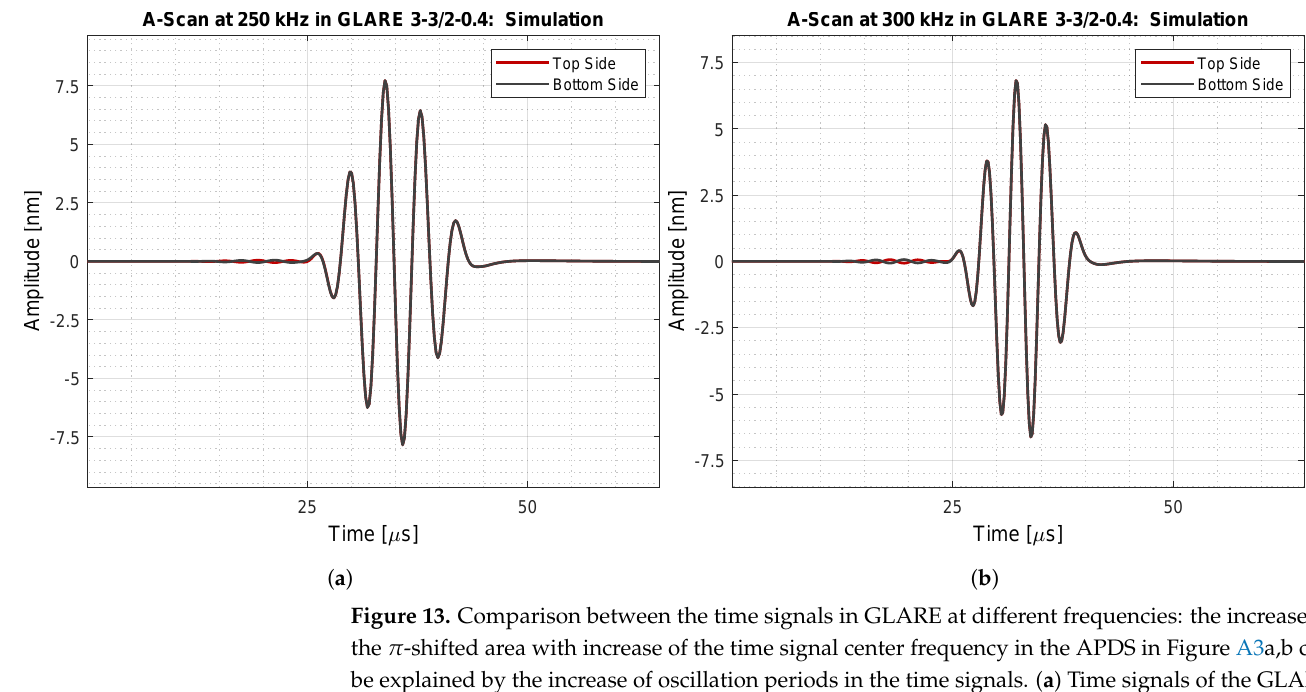
Figure 13. Comparison between the time signals in GLARE at different frequencies: the increase of the π -shifted area with increase of the time signal center frequency in the APDS in Figure A3a,b can be explained by the increase of oscillation periods in the time signals. ( a ) Time signals of the GLARE plate at 250kHz. ( b ) Time signals of the GLARE plate at